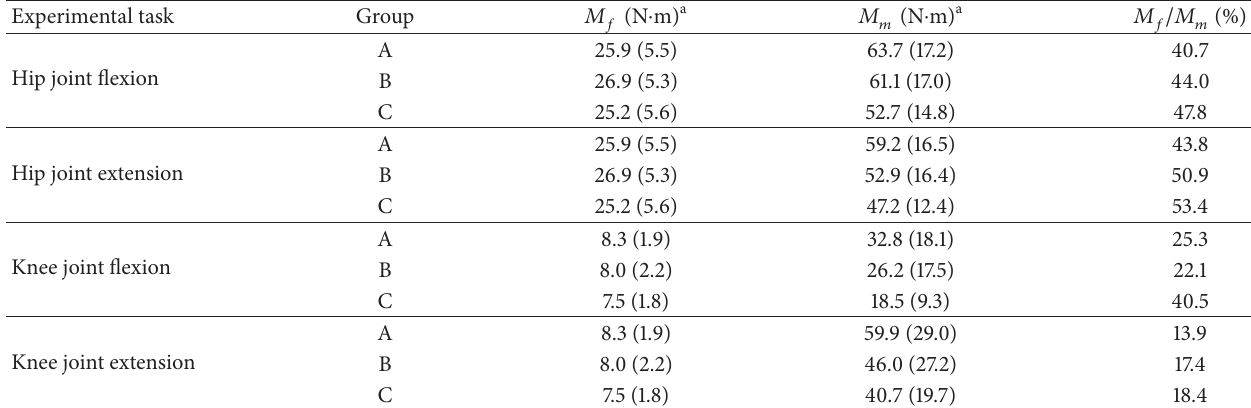
Table 2: Average of 𝑀 𝑓 and 𝑀 𝑚 and ratio of 𝑀 𝑓 to 𝑀 𝑚 (𝑀 𝑓 /𝑀 𝑚 ) .